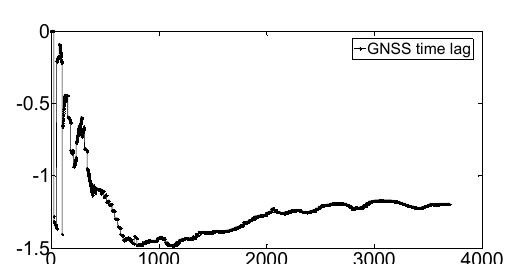
Figure 10. The GNSS time lag in real tunnel experiment